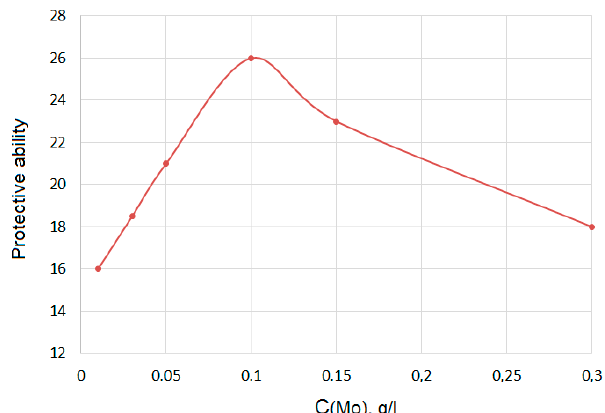
Figure 7. Dependence of the protective ability of oxide-zirconium coatings on the concentration of Mo (VI) in the deposition solution.